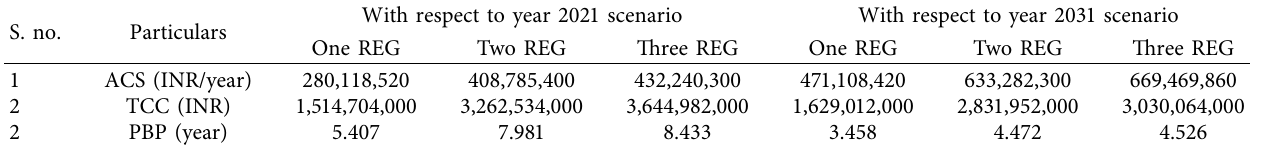
Table 14: Active power loss saving and payback period.